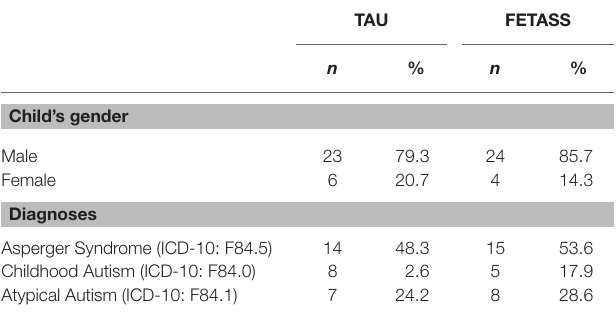
TABLE 1 | Sample characteristics with gender and diagnoses of the children.